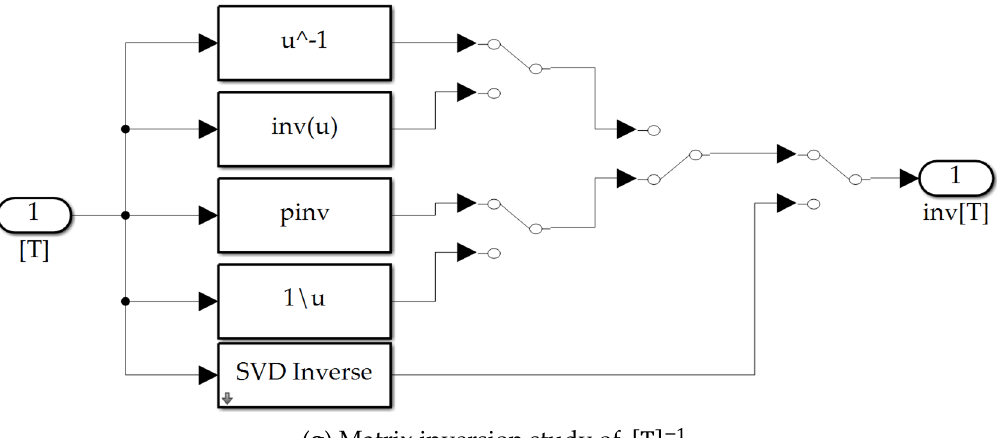
Figure A1. Topologies provided by SIMULINK ® systems used to produce the result presented.